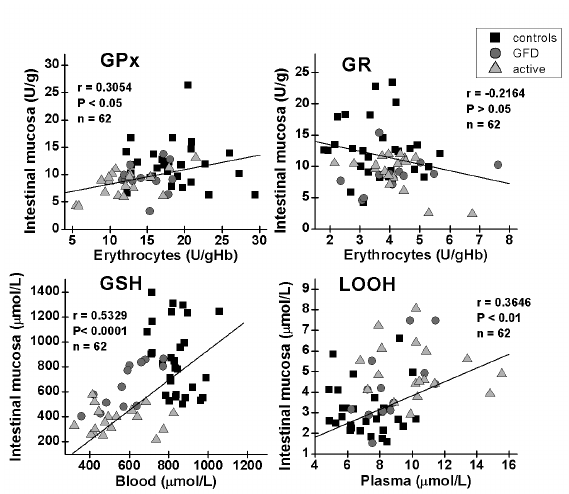
Figure 3. Data plot and coefficients of Pearson’s product moment correlation r among the GPx activitiy, GR activity, GSH concentration and LOOH concentration in small intestinal mucosa and peripheral blood of control subjects, patients on gluten-free diet (GFD) and patients with the active form of the celiac